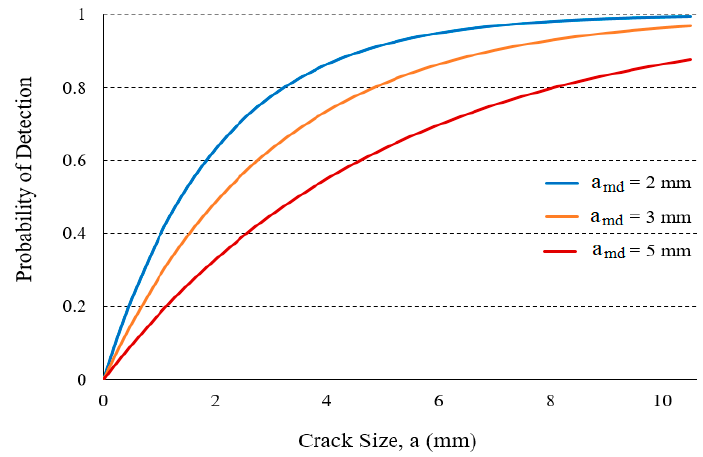
Figure 2. Probability of detection (POD) curves for different mean detectable sizes